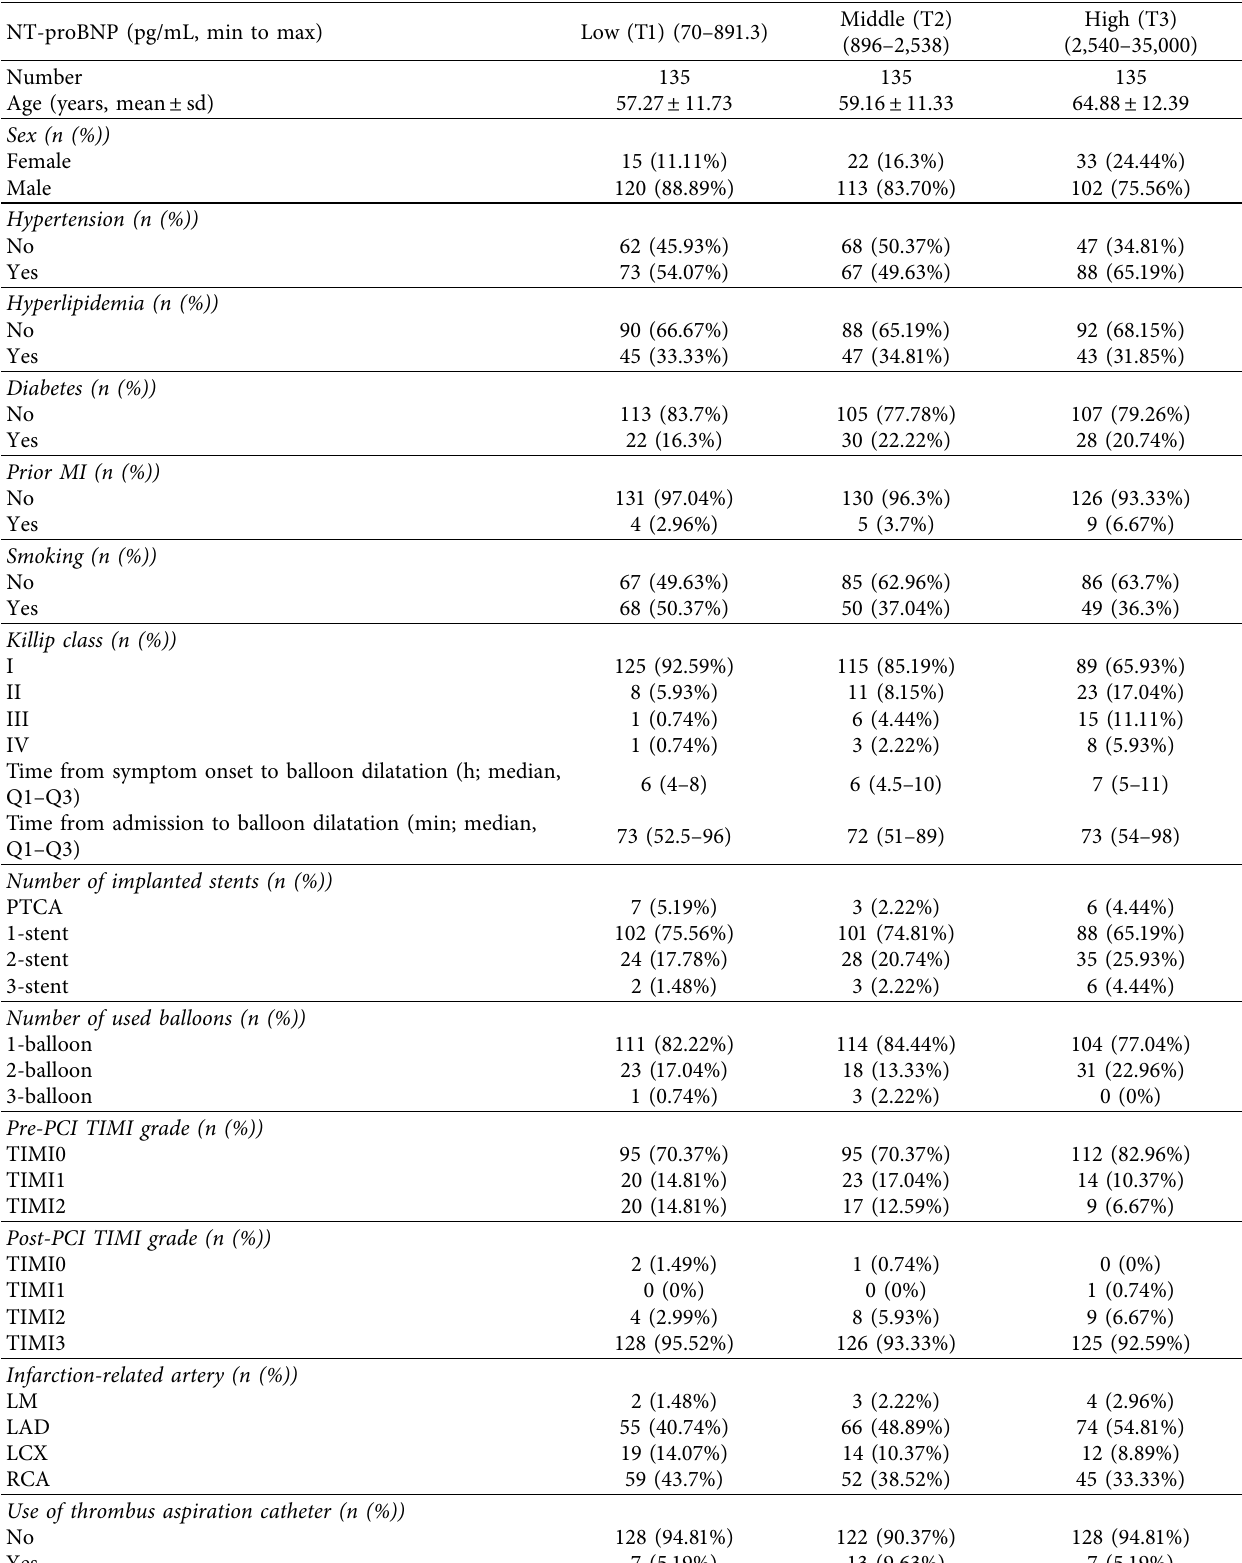
Table 1: Baseline characteristics of the